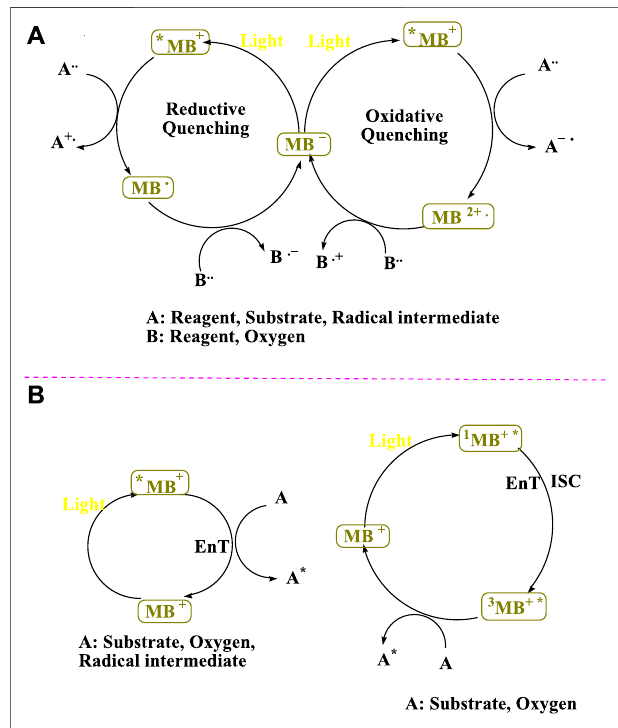
FIGURE 1 | Photocatalytic cycles can be carried out with MB + (Patel et al.,